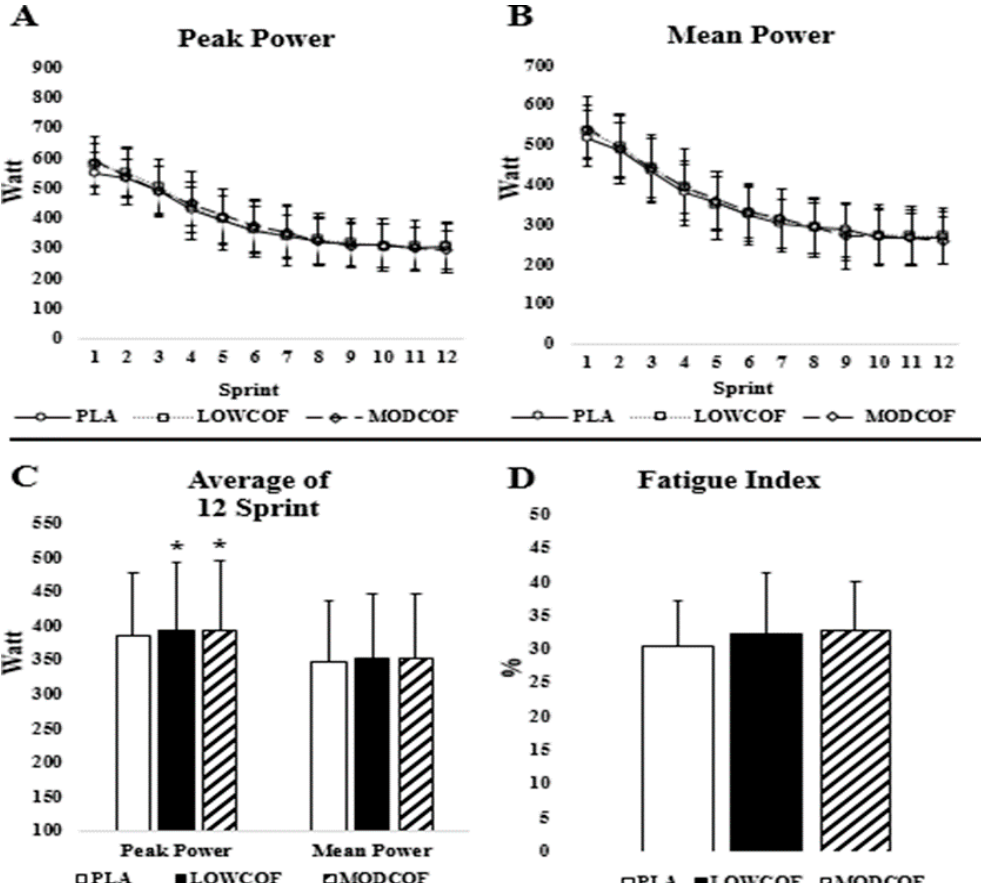
Figure 2. Peak power ( A ) and mean power ( B ) for each sprint across intervals, average peak and mean power output of the 12 × 4 s repeated sprints ( C ), and fatigue index during 12 × 4 s repeated sprints ( D ) test with ingestion of placebo (PLA) or 3 mg·kg − 1 of caffeine from coffee (LCOF) or 6 mg·kg − 1 of caffeine from coffee (MCOF). * : Significantly different from PLA at p < 0.05.